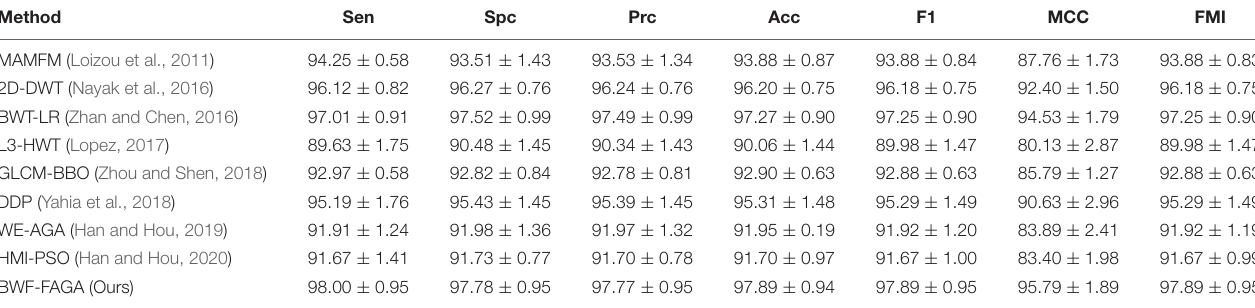
TABLE 7 | Comparison with AI-based MS recognition methods (unit: %). Method